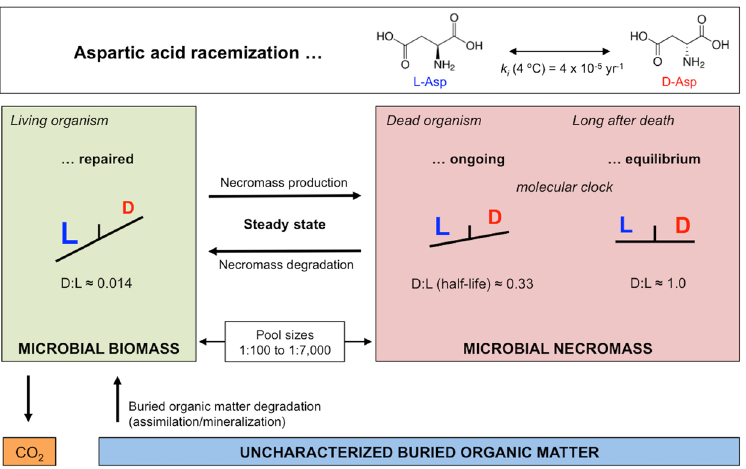
Figure 7. Scheme of the D:L-amino acid model. Conceptual scheme showing D:L-Asp ratios in bio- and necromass as well as different pools of amino acids with indications of the amino acid-cycling between pools. Pools are microbial biomass (vegetative cells + endospores), microbial necromass (necromass amino acids) and uncharacterized buried organic matter (not amino acids). Modified after ref.